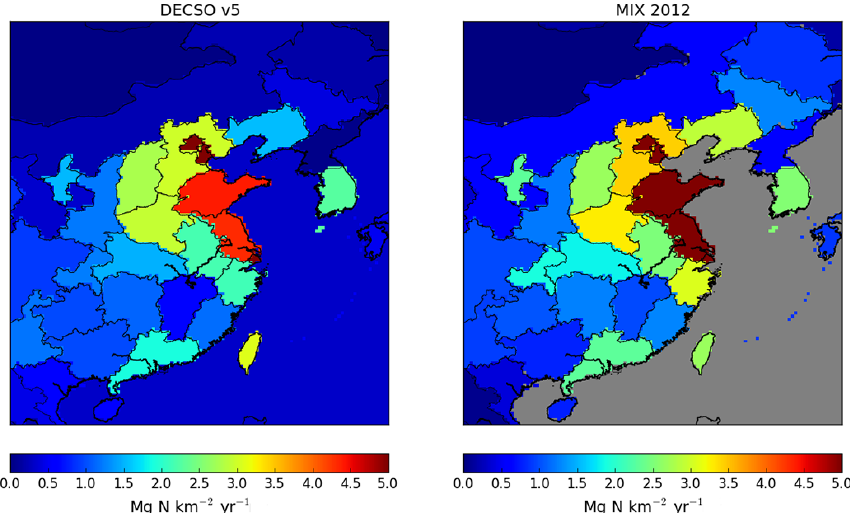
Figure 10. Annual emissions on a provincial level derived with DECSO v5 and from the MIX (2012) inventory, used for China and outside China respectively. Emissions over sea are not included in the MIX